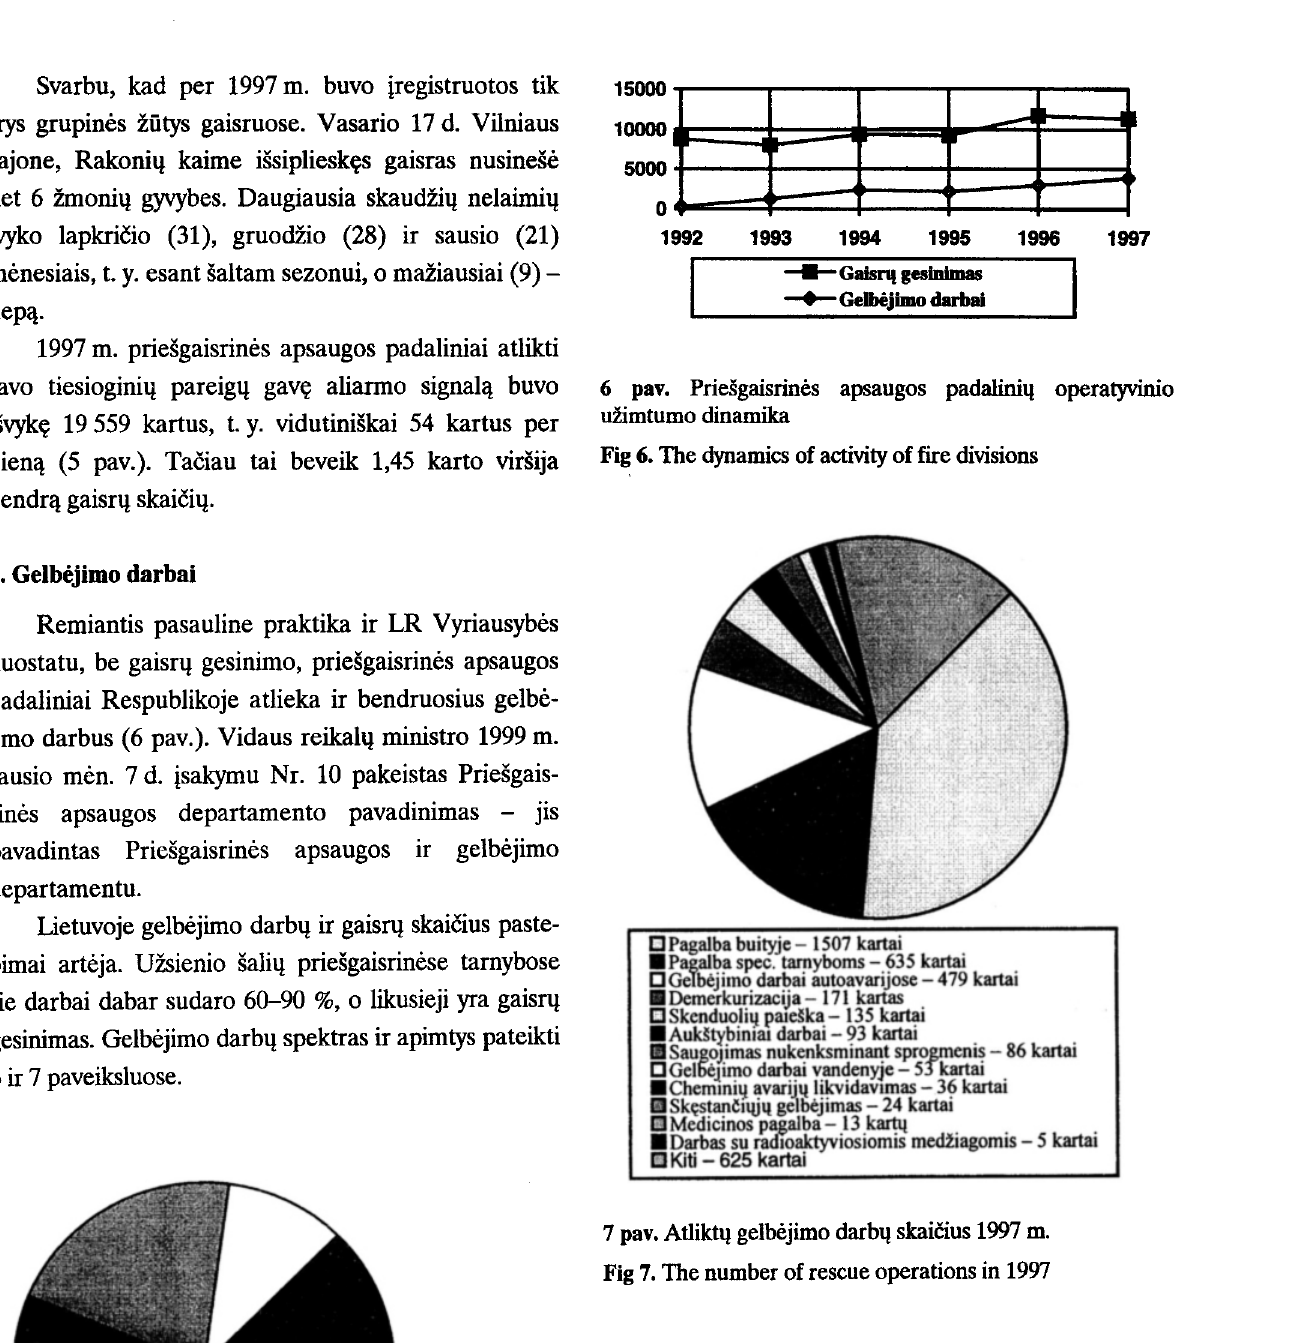
7 pav. Atliktq gelbejimo darbq skaiCius 1997 m. Fig 7. The number of rescue operations in